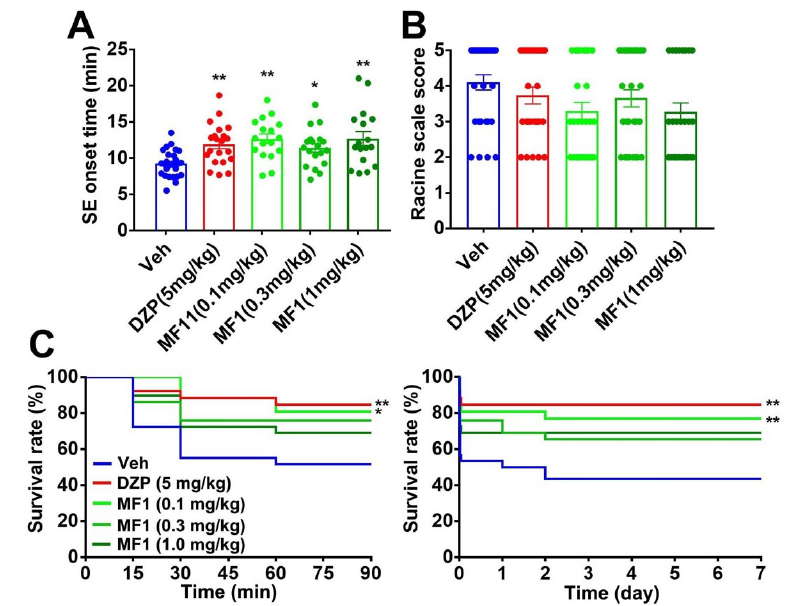
Table 1. Acute effects of MF1 and DZP on epileptic seizure in PTZ-treated mice. ** p < 0.01 vs. vehicle- administered PTZ-treated mice. ( n = 10 per group). GTCs: generalized tonic-clonic seizures, i.p.: intraperitoneal, p.o.: per